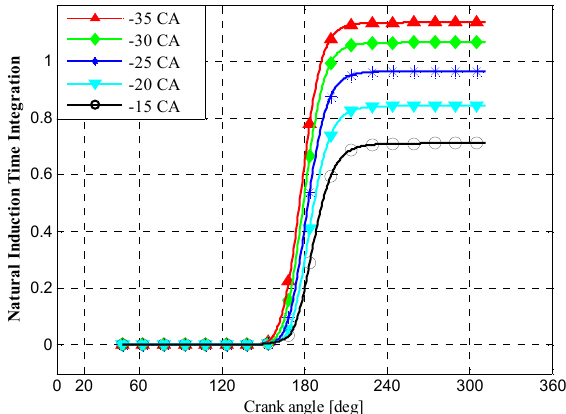
Figure 24. Natural induction time integration with different advanced ignition angles.